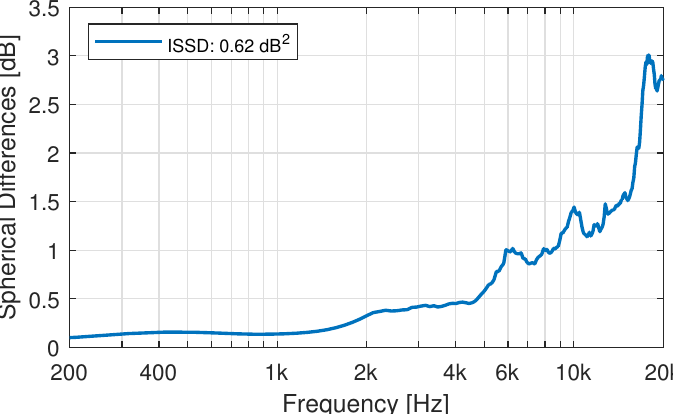
Figure 12. Spherical Differences between the simulated HRTF of the anonymized and the non- anonymized head and torso model of one exemplary